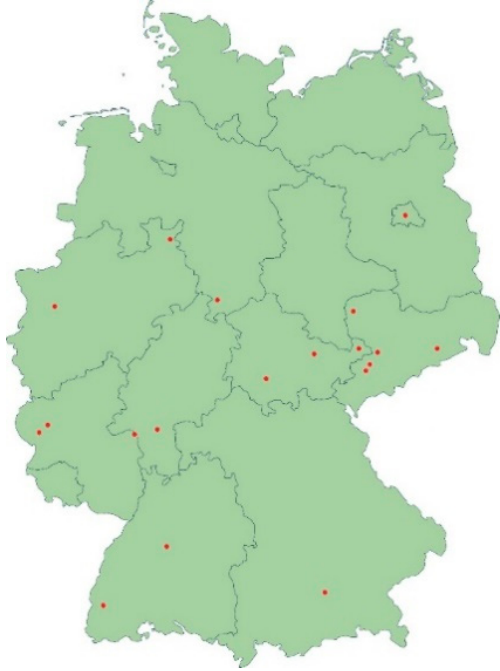
Figure 6. Geographical distribution of patients with dermatophytoses due to the Indian genotype of T . mentagrophytes identified in this study. Strains of T . mentagrophytes Type VIII were isolated in nearly all parts of Germany, in large cities like Berlin, Munich and Leipzig as well as in small towns and rural areas.